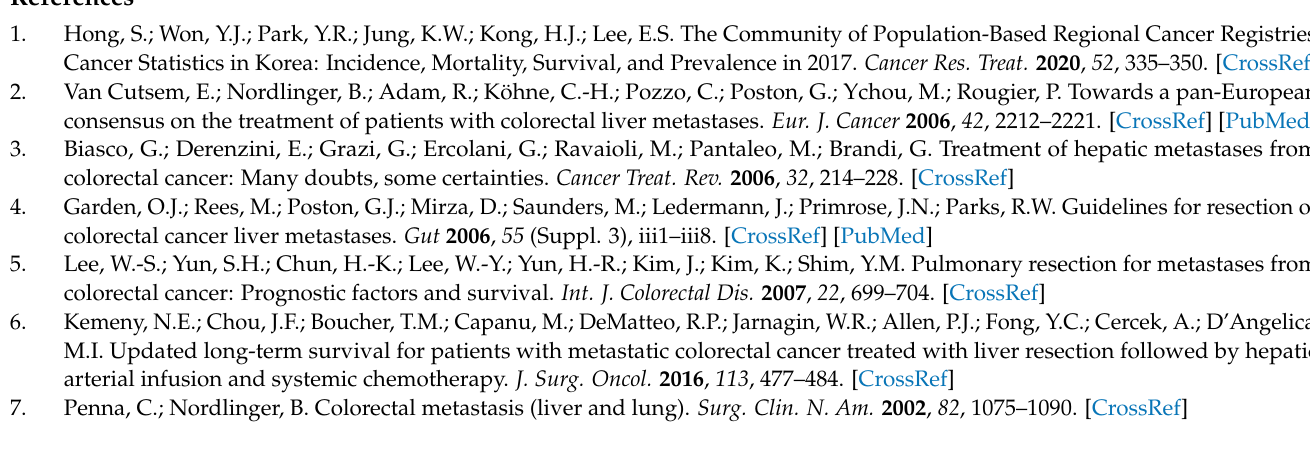
(50 genes). Table S2: Clinical characteristics of all participants and their genomic information with tumor and